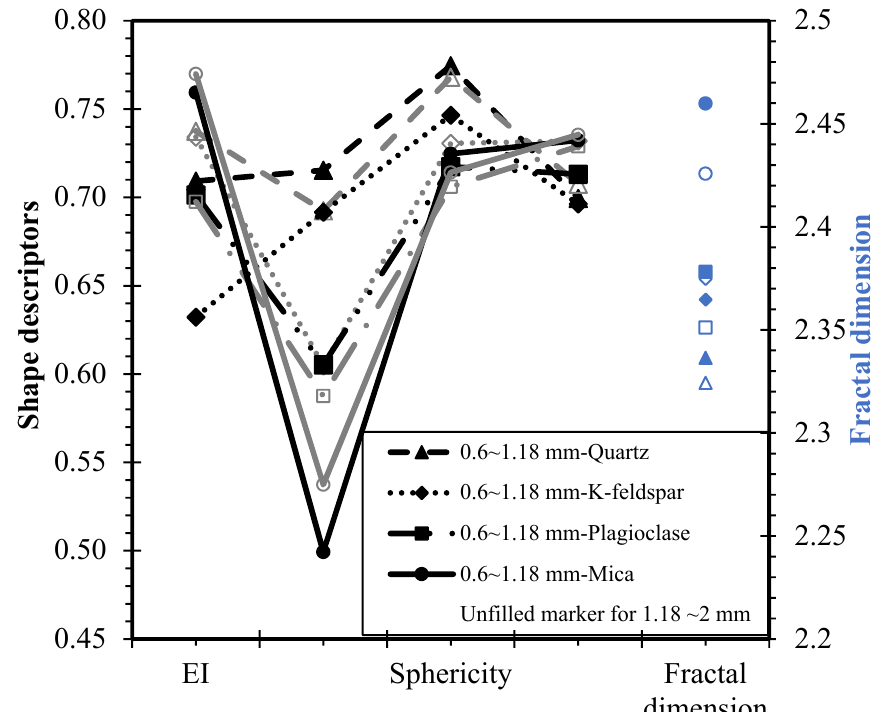
Figure 7. Variation of shape descriptors with particle sizes for different minerals. Blue symbols refer to fractal dimension. Grey solid and dotted lines are for shape descriptors for particle size 1.18 to 2 mm.